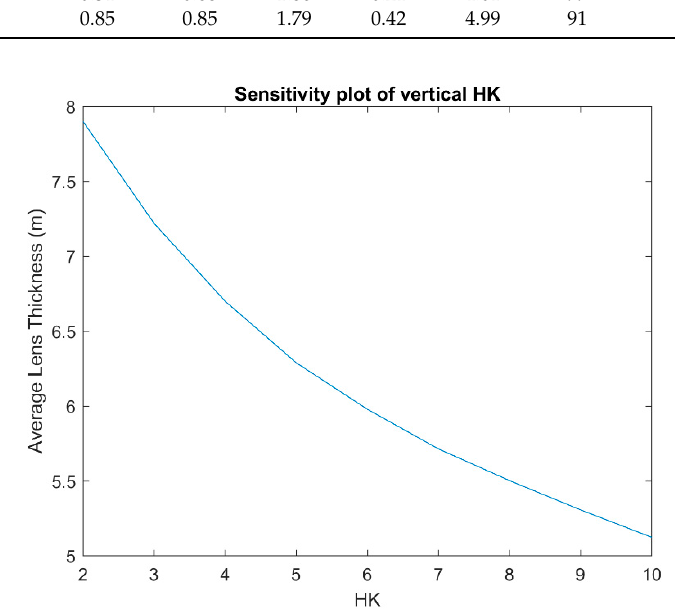
Figure A1. Sensitivity plot of vertical hydraulic conductivity (HK) .